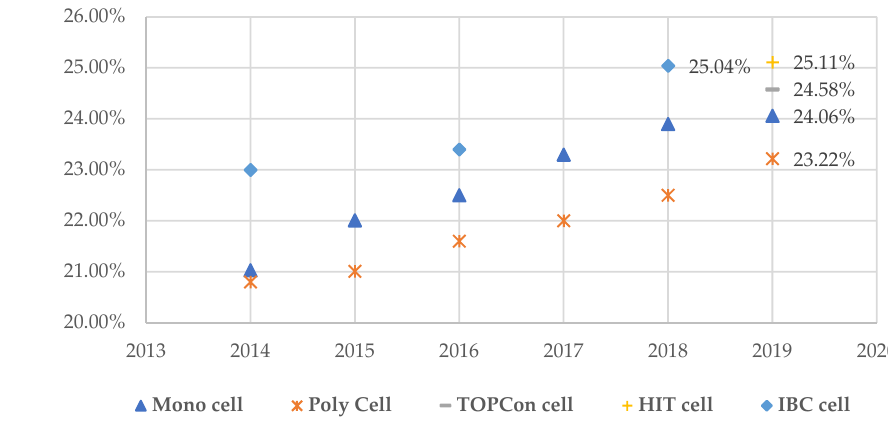
Figure 9. World record of conversion efficiency broken by Chinese solar PV companies (2013– 2019). Source: Nation Renewable Energy Laboratory: https://www.nrel.gov/pv/cell-efficiency.html (accessed on 23 April 2021).